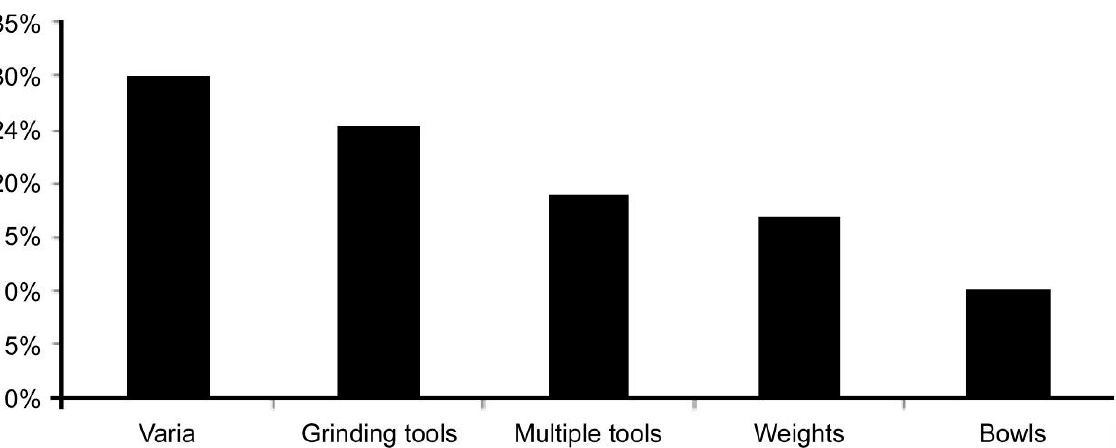
Figure 3. Frequencies of the five main tool categories found at the Ohalo II loci (n=71), by descending order. Table 1. Frequencies of the five major tool types according to loci.